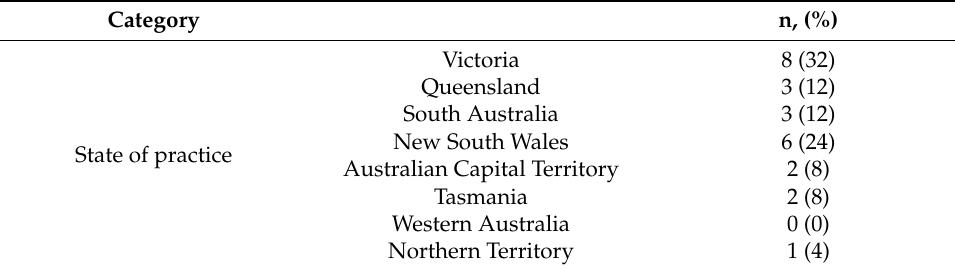
Table 1. Demographic profile of